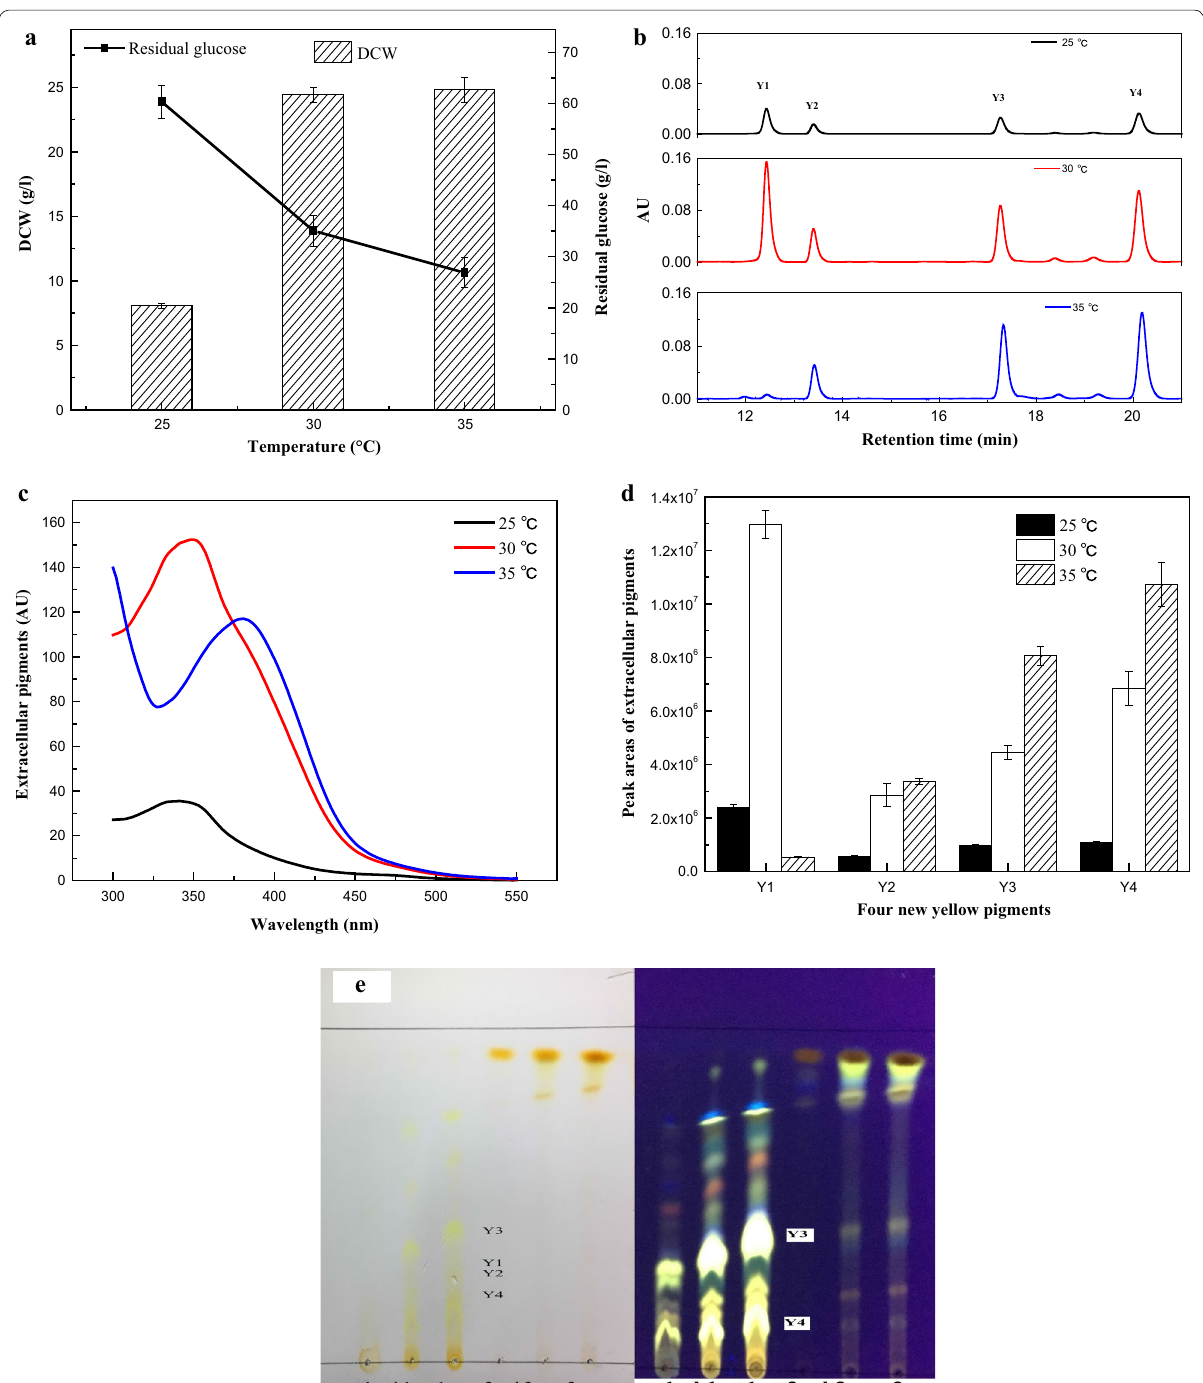
Fig. 1 Cell growth and pigment production in submerged fermentation of M. ruber CGMCC 10910 at 25, 30, and 35 °C. a Residual glucose (g/L) and DCW (g/L). b The profile of extracellular pigments determined by HPLC-PDAD at 388 nm. c UV–Visible spectra of extracellular pigments. d Yields of extracellular four water-soluble yellow pigments. e TLC analysis of the extracellular and intracellular pigments, the left one is in visible light, the right one is in UV lamp (365 nm). “a1, b1, c1”, respectively, represent extracellular pigments of fermentation temperature at 25, 30, and 35 °C, and “a2, b2, c2” represent intracellular